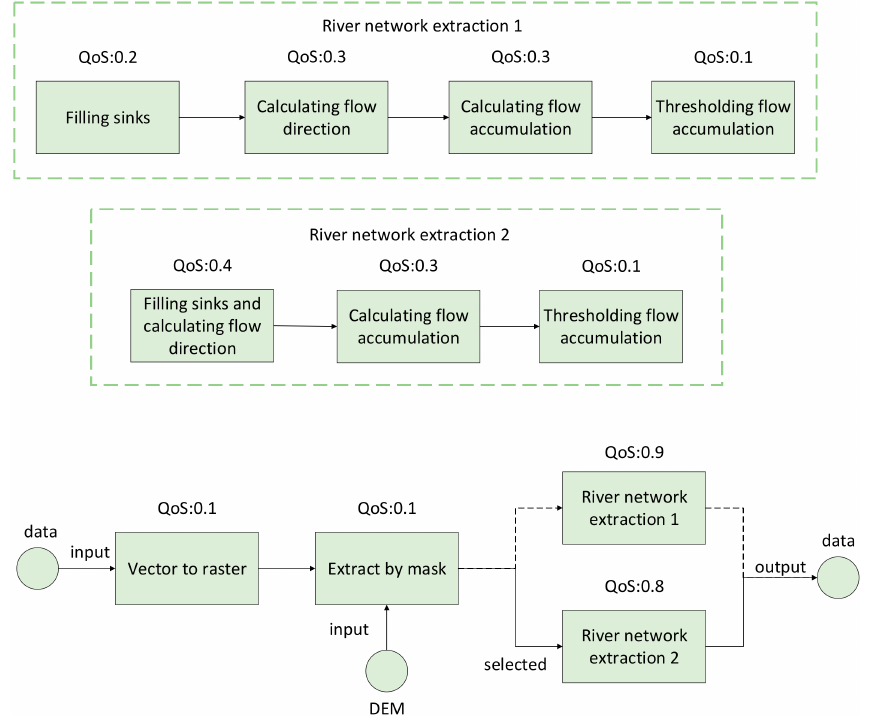
Figure 8. Service chain of river network extraction.